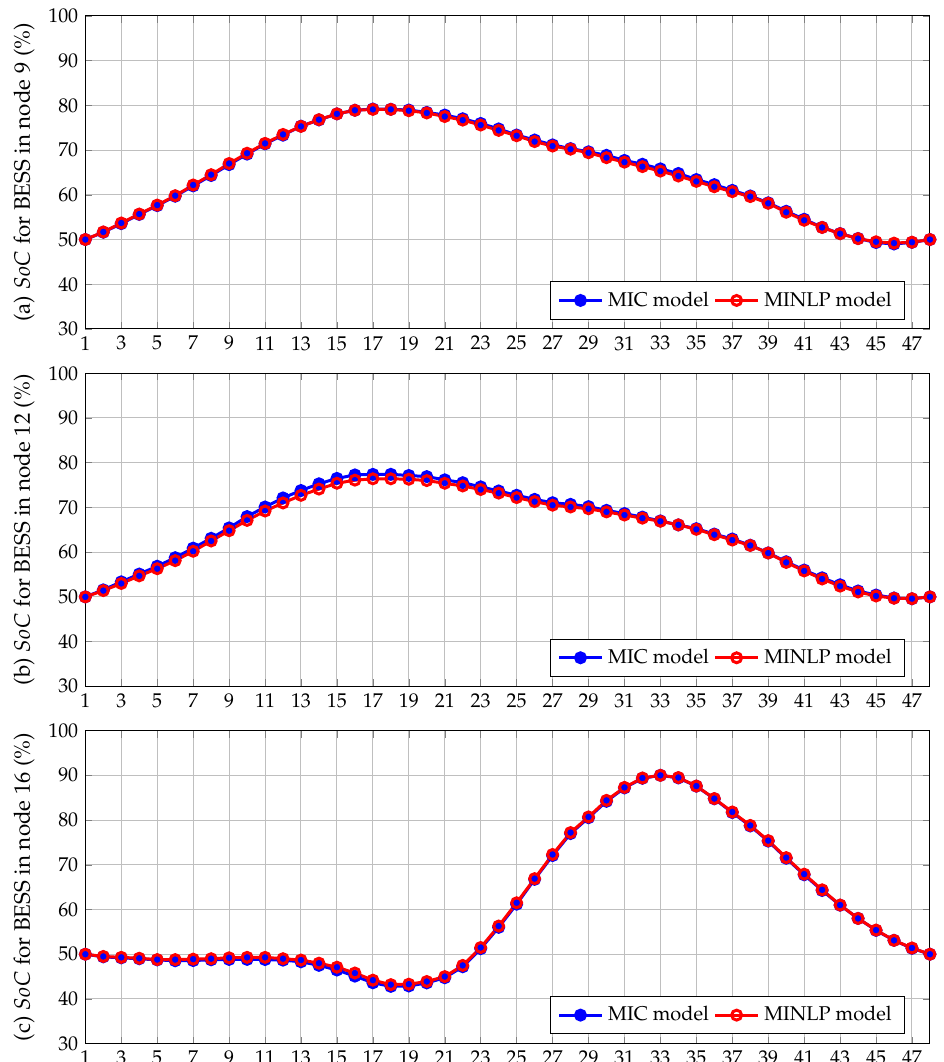
Figure 3. Comparison between the exact MINLP model and the proposed MIC one for Case 4: ( a ) SoC for battery at node 9, ( b ) SoC for battery at node 12, and ( c ) SoC for battery at node